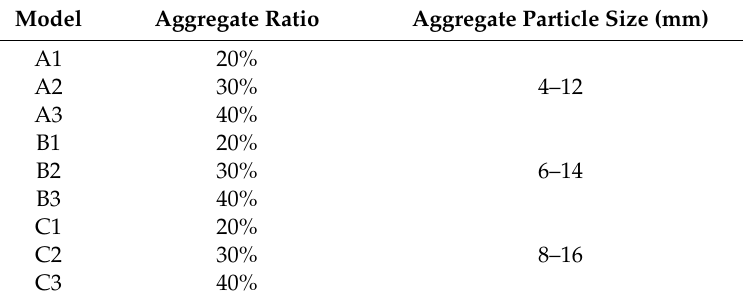
Table 2. Parameters of numerical models.